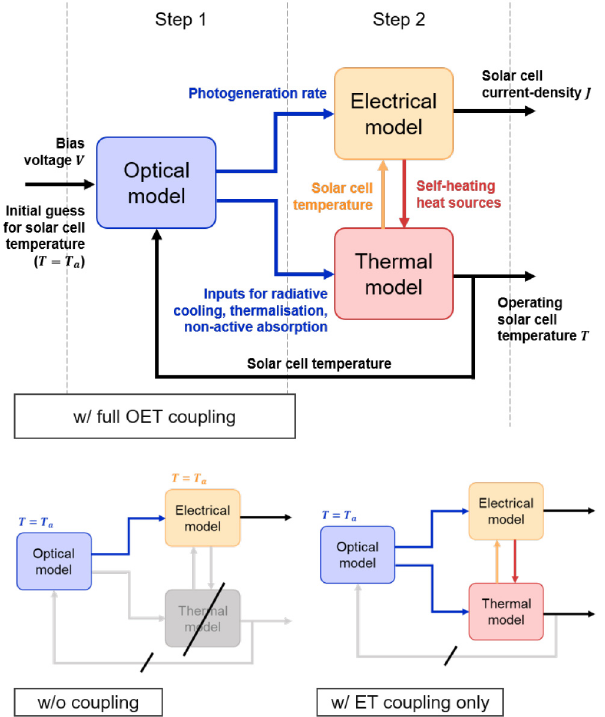
Fig. A.1. Flow chart of the different coupling scenarios studied in the present paper ( “ w/full OET coupling ” , “ w/o coupling ” , “ w/ET coupling only ” ). For the full OET coupling scenario, the main inputs, outputs, and interconnections are speci fi ed.